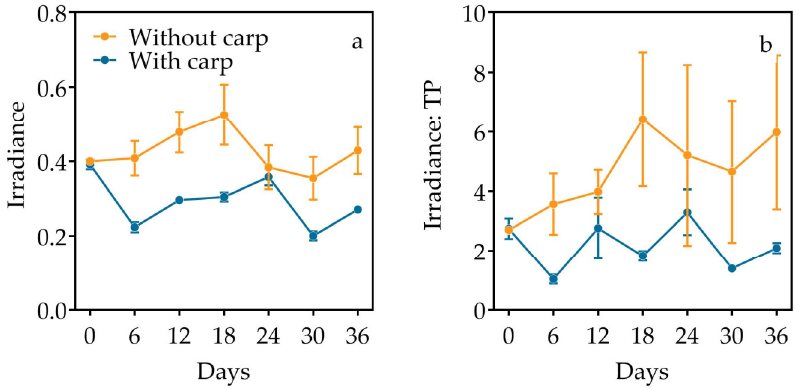
Figure 2. Comparisons of ( a ) irradiance and ( b ) irradiance to total phosphorus (Irradiance/TP) ratios between the two treatments. Values denote mean ± SE ( n = 3).